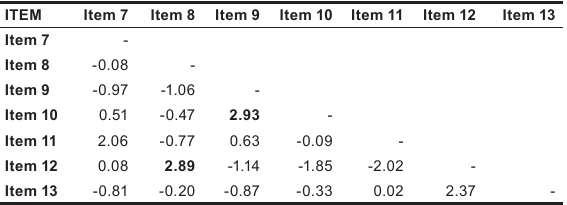
TABLE 9 Standardised residuals for Merchandise dimension – Mall intercept study